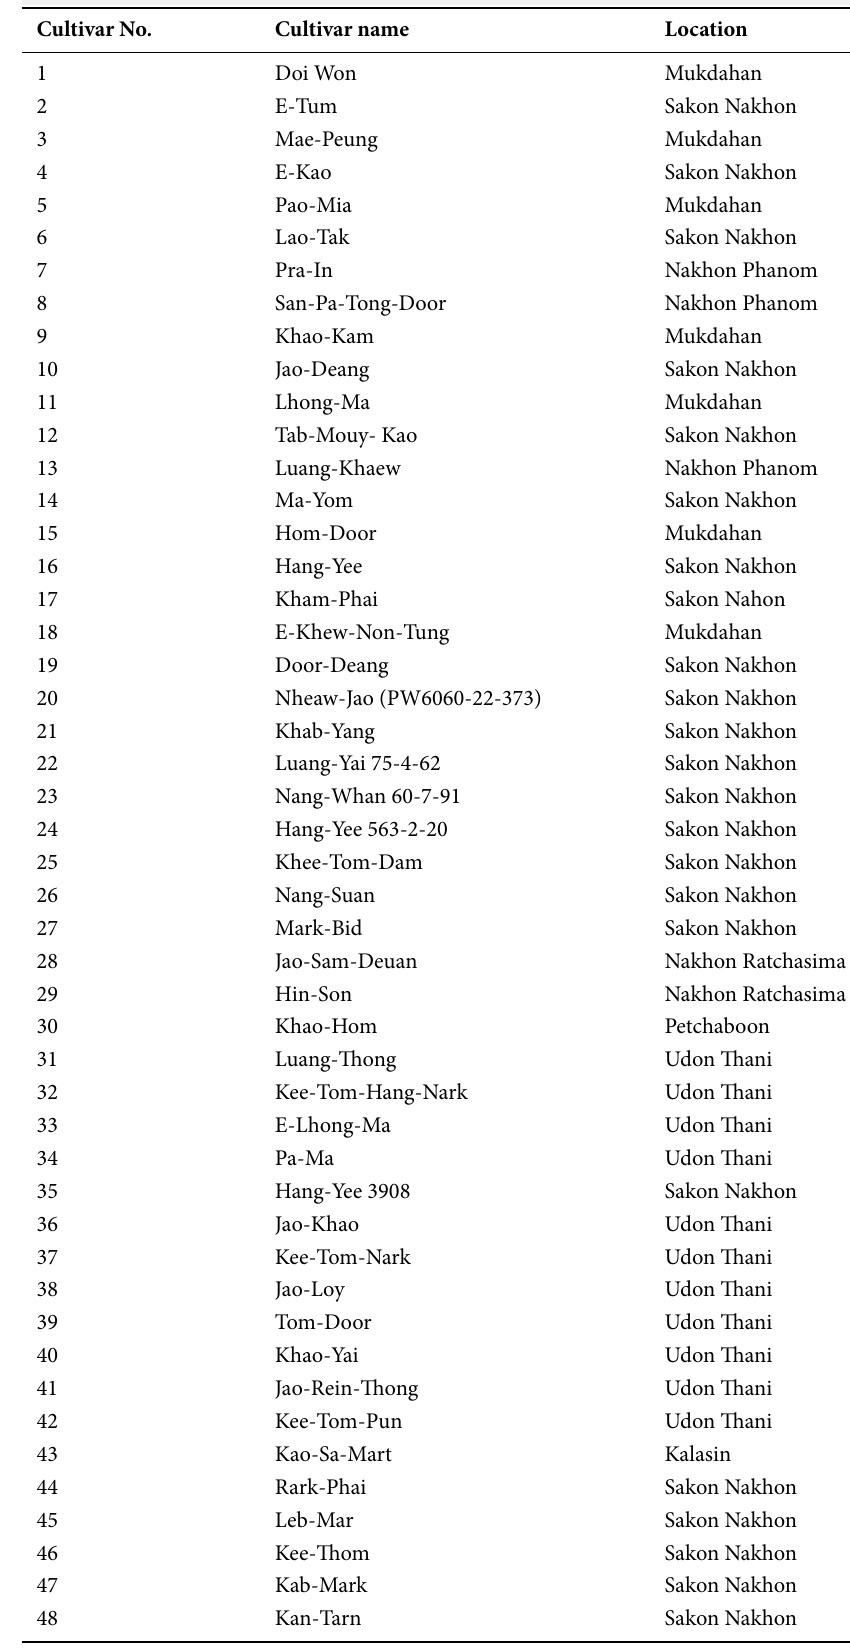
Table 1 List of 80 rice cultivars collected from the northeastern region of ailand (Phansak et al.,